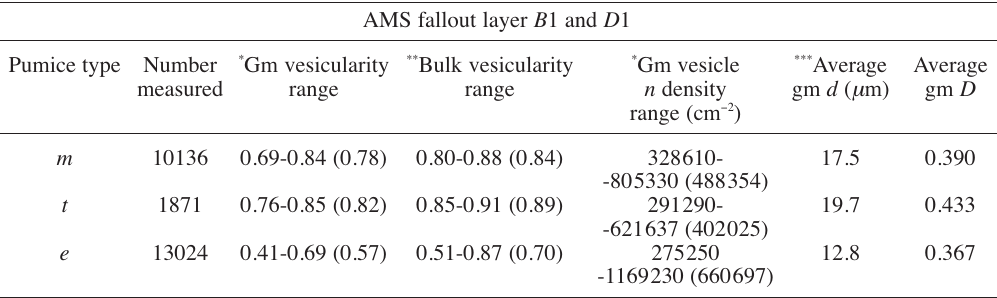
Table II. Summary of textural